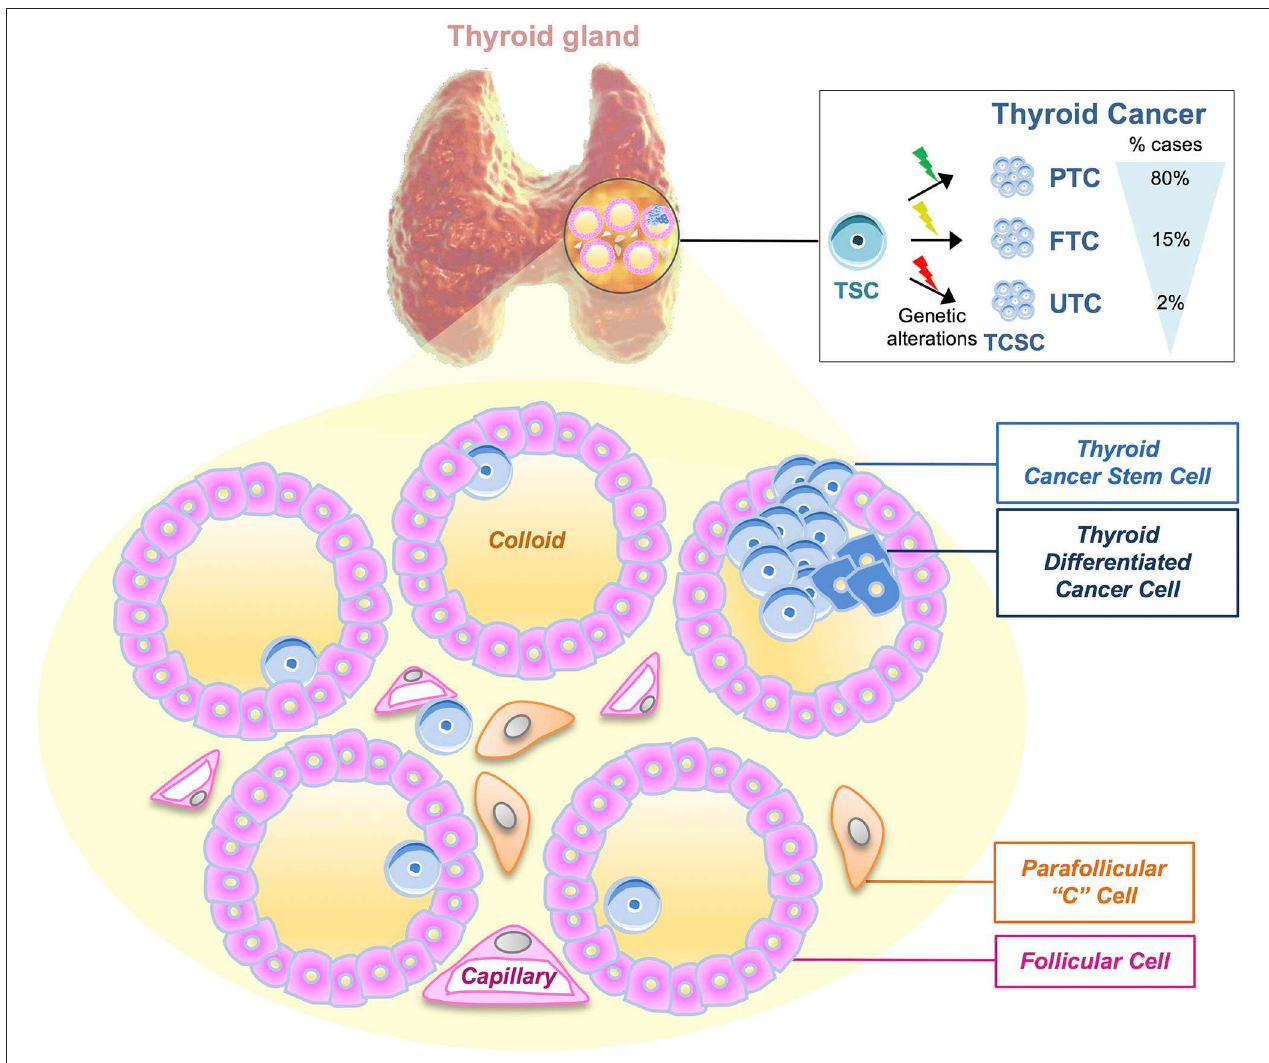
FIGURE 1 | Thyroid tumors and thyroid cancer stem cell genetic model. Thyroid cancers (TCs) are heterogeneous diseases varying from well-differentiated [papillary thyroid carcinomas (PTCs), follicular thyroid carcinomas (FTCs)] to undifferentiated tumors (UTCs). According to the most recent thyroid cancer stem cell model, the cell of origin of TC may be represented by the same cancer stem cell, which is subjected to different types of genetic mutations, leading to the development of PTC (80% of cases), FTC (15%), and UTC (2%), respectively. The model shown represents the microscopic structure of thyroid follicles, in which walls of follicular cells surround the follicle lumen filled with colloid, the center of thyroid hormone production. Moreover, following this model, thyroid cancer stem cells (TCSCs) along with thyroid differentiated cancer cells may populate the thyroid follicle. Parafollicular “C” cells are the cells of origin of medullary thyroid carcinoma